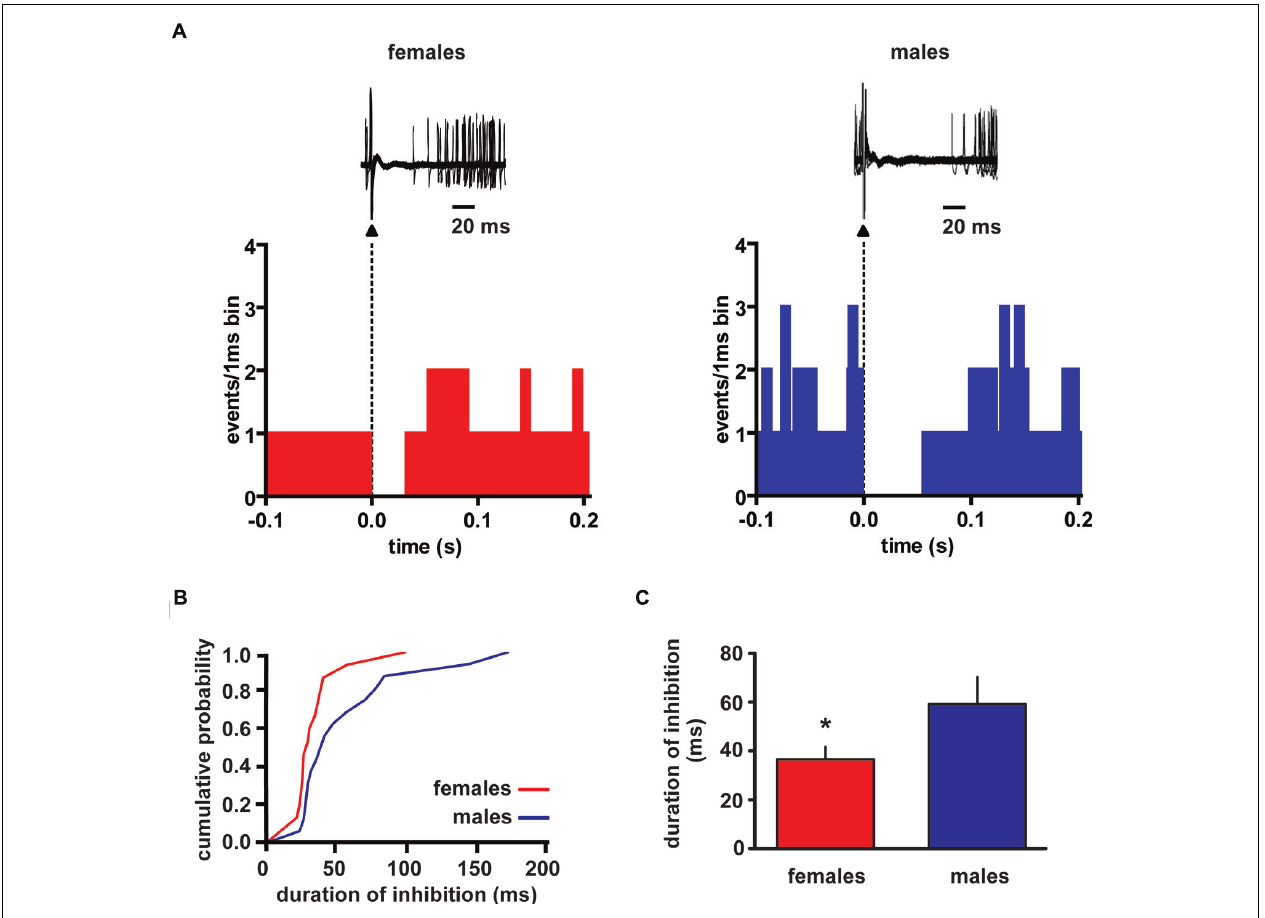
FIGURE 1 | Rostromedial tegmental nucleus (RMTg) stimulation induces a shorter inhibition of VTA DA neuron spontaneous activity in female LH rats. (A) The top panel shows traces acquired from a digital oscilloscope representing typical examples of a VTA DA neuron recorded in female (left panel) and male (right panel) LH rat, whose stimulation from RMTg was evoked by delivering rectangular current pulses (1 Hz, 0.5 mA, 0.3 ms). RMTg-stimulation produced a full suppression in firing activity of VTA DA neurons for ∼ 36 and ∼ 60 ms in